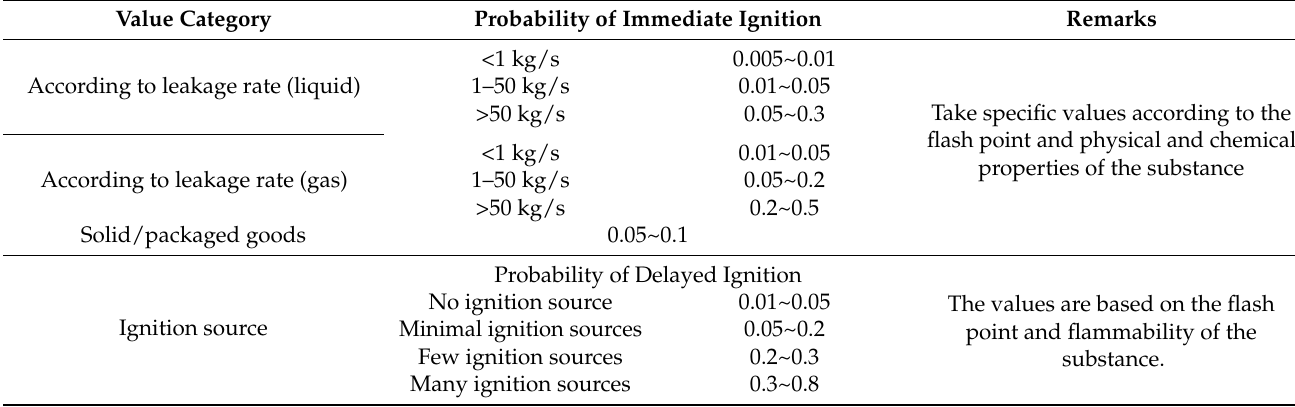
Table 11. Reference values for the probability of immediate and delayed ignition of a spill of dangerous goods from a ship.